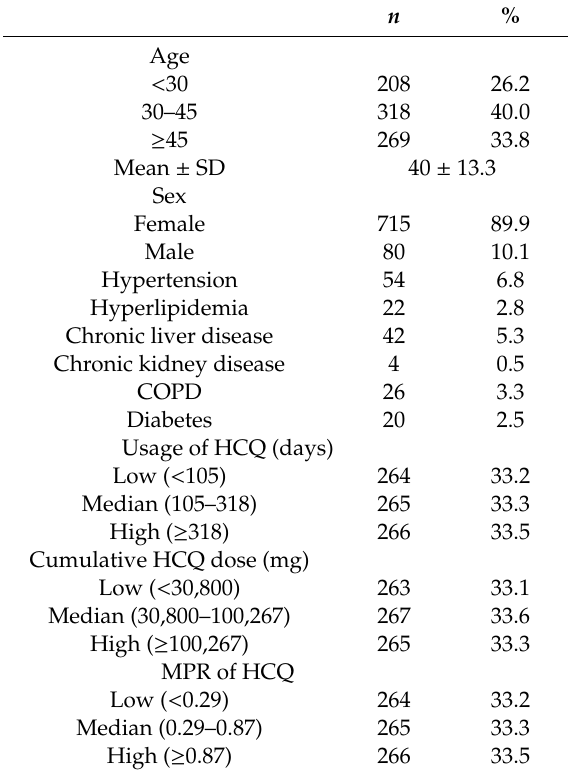
Table 1. Demographic characteristics of SLE